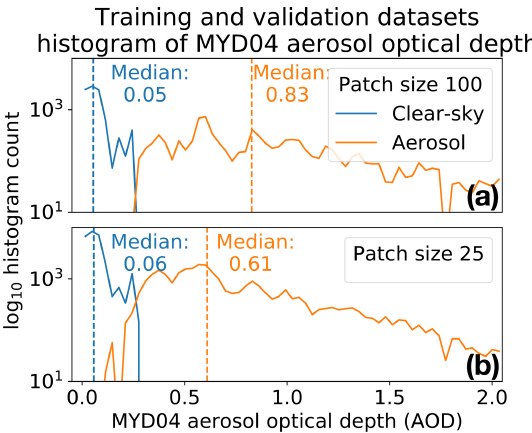
Figure 13. Panels (a) and (b) show histograms of the median MODIS MYD04 aerosol optical depth per patch of the training and test datasets of patch sizes 100 and 25 pixels, specifically for the clear-air and aerosol labels. There is a clearer AOD separation be- tween the clear-air and aerosol labels for the (a) 100-pixel patch size datasets compared to that of the (b) 25-pixel patch